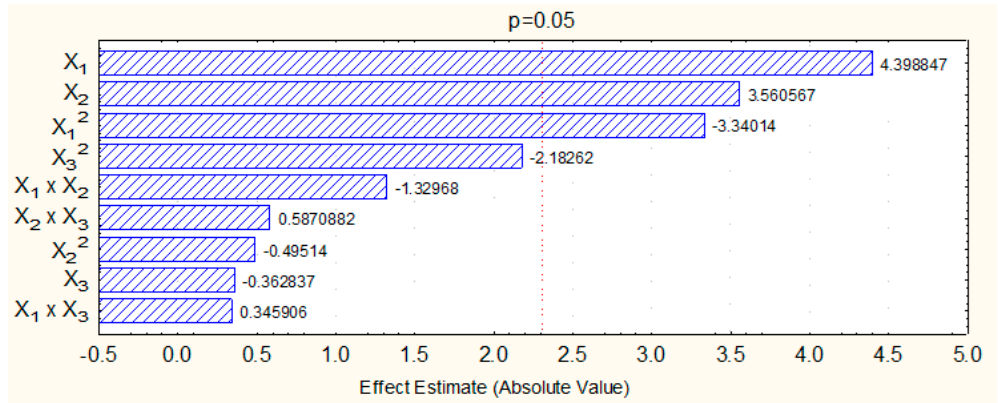
Figure 2. Pareto diagram showing the e ff ect of independent parameters biocatalyst concentration ( x 1 ),